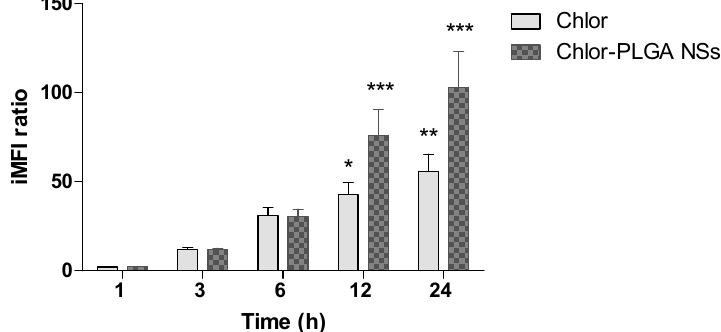
Figure 9. Chlor uptake by DU-145 cells. DU-145 cells were incubated with Chlor and Chlor-PLGA NSs (5 µM) for 1, 3, 6, 12 and 24 h. Fluorescent signal was detected using a flow cytometer at 488 nm excitation to measure the intracellular Chlor and expressed as the iMFI ratio calculated as reported in Materials and Methods. Statistical significance vs. 1 h incubation: * p < 0.05; ** p < 0.01; *** p < 0.001.